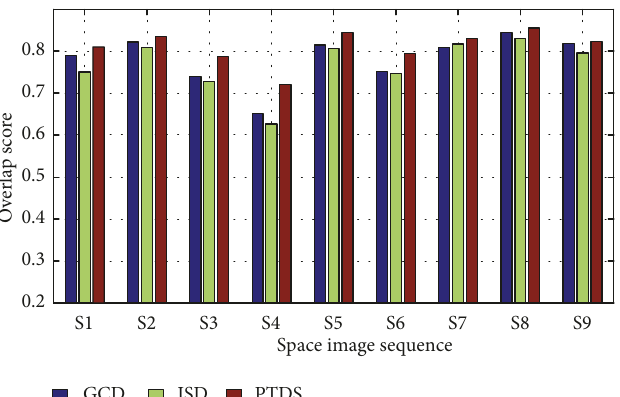
Figure 6: Comparison results of the average overlap score.